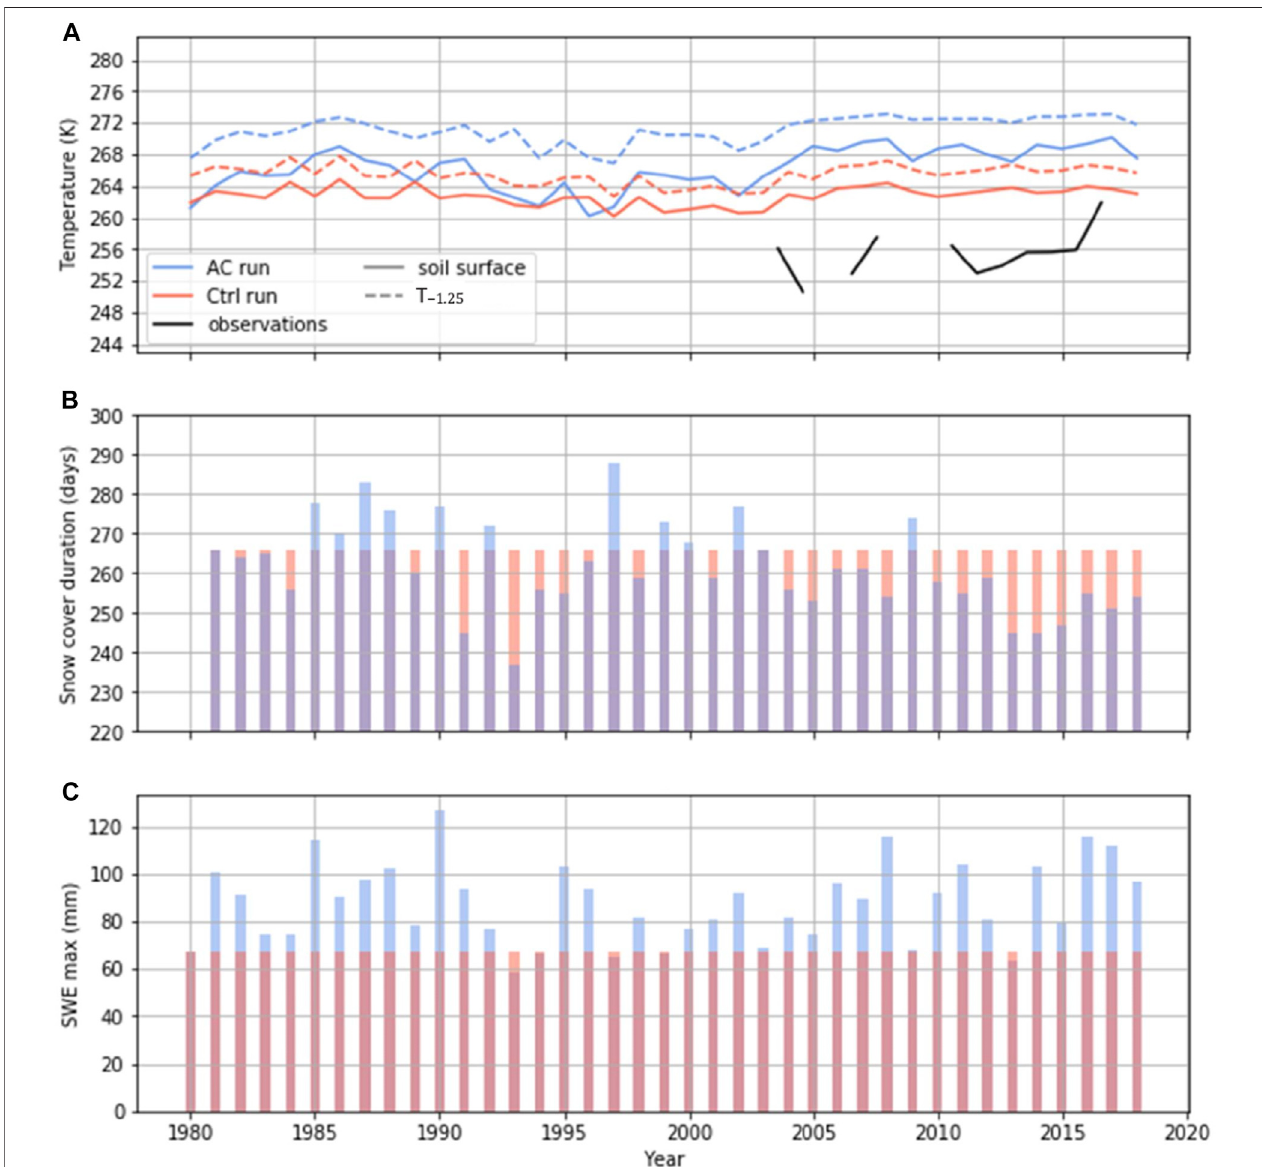
FIGURE10| Meansoilsurfacetemperature(solidline)andsoiltemperatureat − 1.25 mdeep(dashedline)overwinter(December,January,FebruaryandMarch)at the Samoylov site for Arctic Crocus (AC) simulations (blue), control (Ctrl) simulation and observation (black) (A) , snow cover duration in days for AC simulation (blue) and Ctrl simulation with constant snow (orange) (B) and maximum of snow water equivalent (SWE) for AC simulation (blue) and Ctrl with constant snow (orange) (C) .